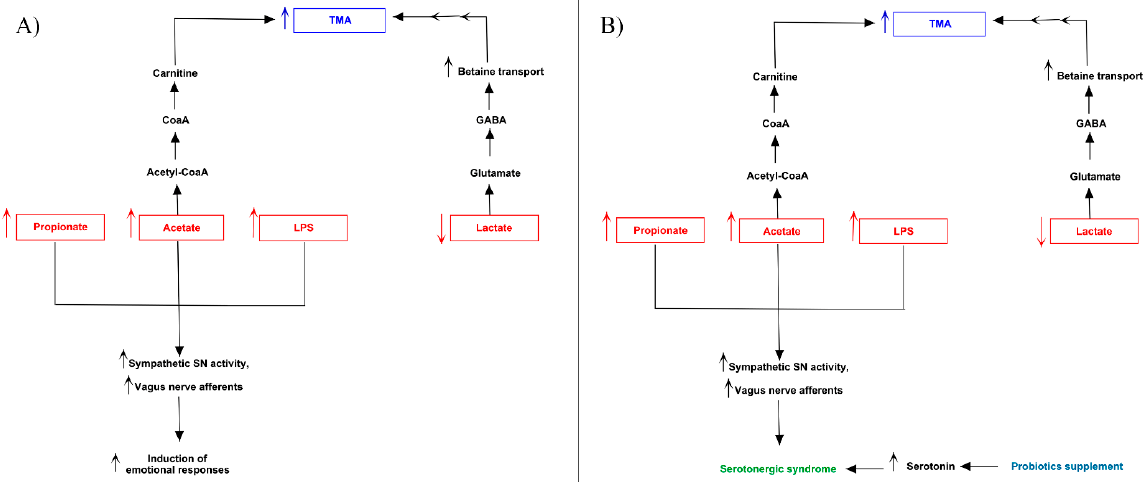
Figure 8. Biochemical pictures of TMAU patients 1 and 6. The panel represents how metabolites produced directly or indirectly by microbiota of patients 1 ( A ) and 6 ( B ) could influence the biosynthesis/release of neurotransmitters (in particular serotonin) and the production/accumulation of TMA.